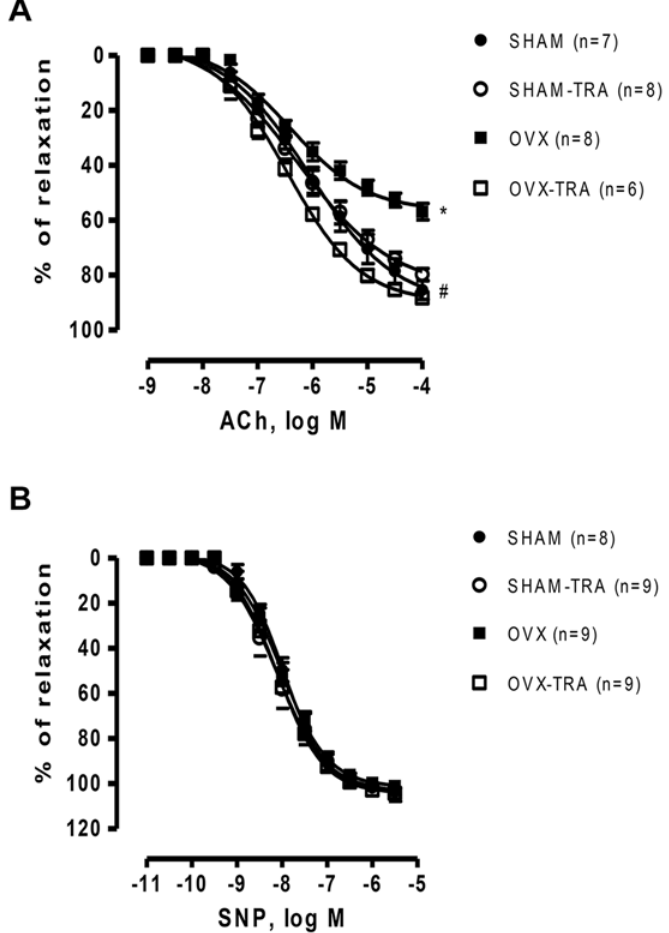
Fig 1. Concentration — response curve to acetylcholine (A) and sodium nitroprusside (B) in aortic rings from SHAM, SHAM-TRA, OVX and OVX-TRA. The numbers shown in the legend represent the number of animals analyzed in each group. Results are expressed as means ± SEM. Two-way ANOVA: * p < 0.01 in comparison to SHAM, # p < 0.01 in comparison to OVX.